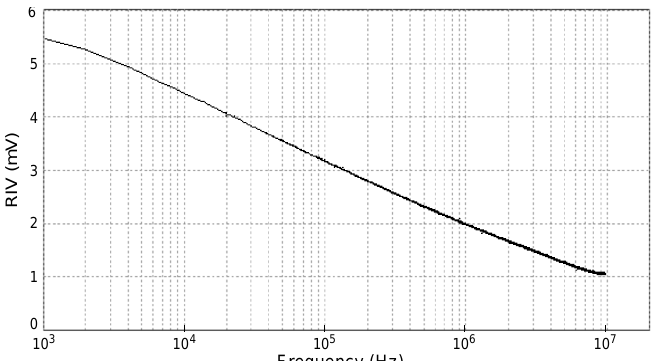
Figure 17. Radio interference voltage (RIV) in coupling device for nominal phase-to-ground voltage on the bushing.